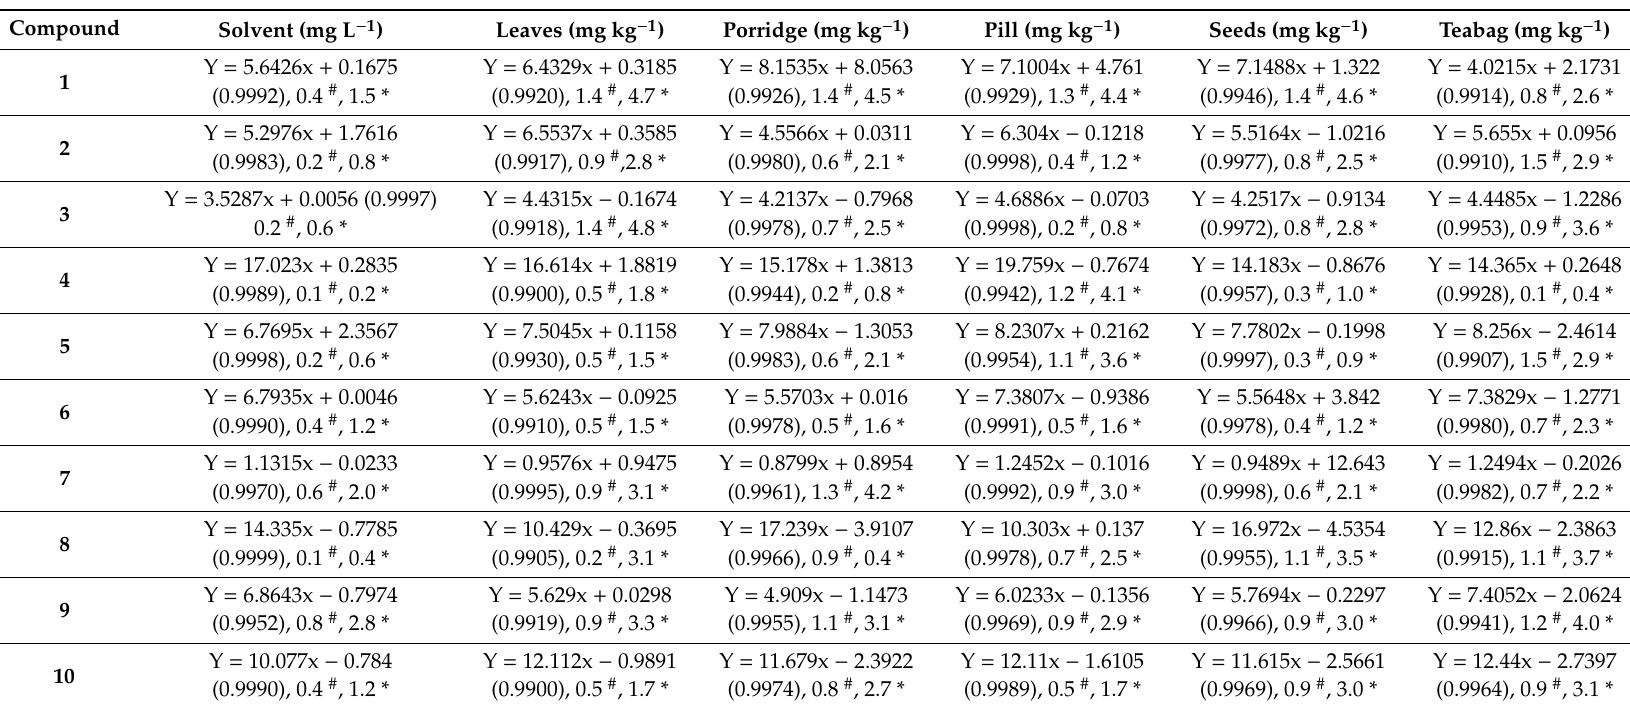
Table 1. Linear regression equations (correlation coe ffi cients) where Y is the response of the compound and x is the concentration of the compound, limits of detection # , and limits of quantification * for the solvent and di ff erent